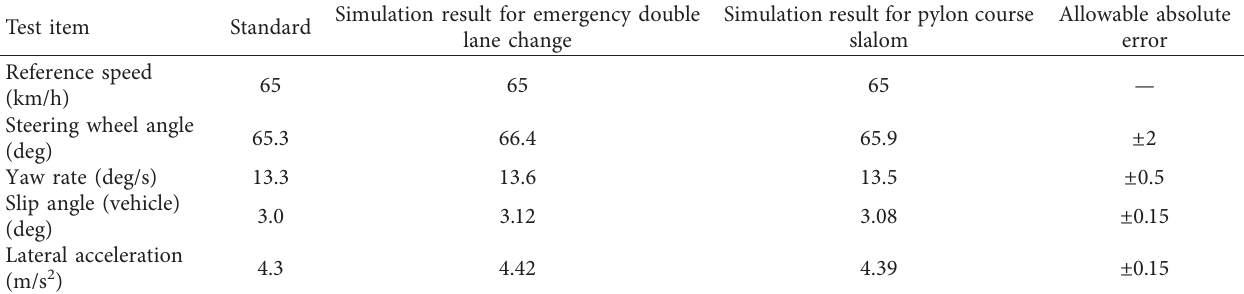
Table 2: Comparison of simulation results and specifications in GB/T6323.1-2014. Test